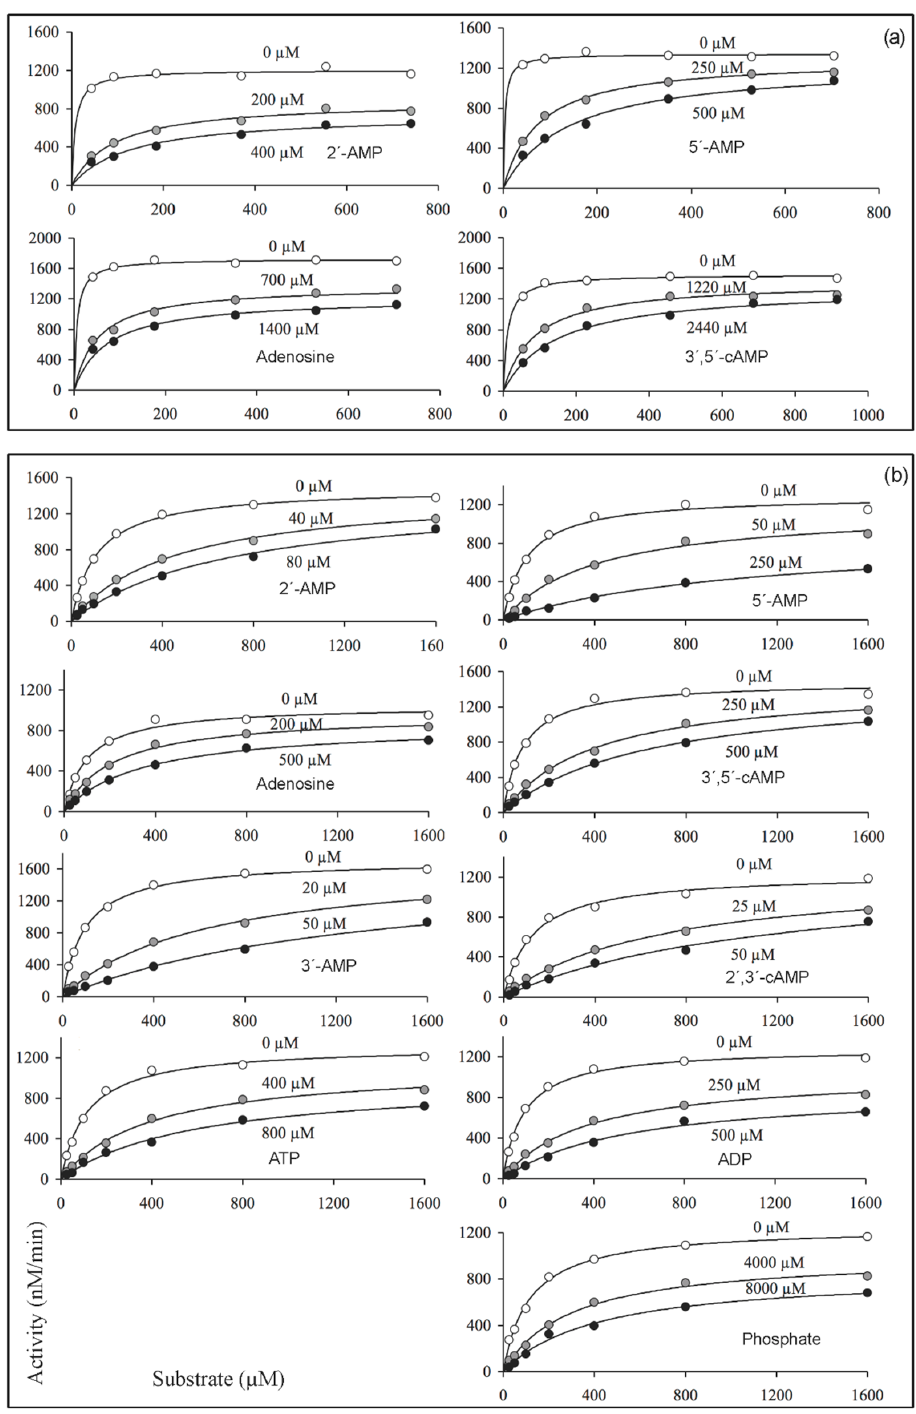
were recorded with 750 µM bis-4-NPP as the substrate. The curves were obtained by fitting the equation for a mixed partial inhibition to the experimental data, as in Figure 5.